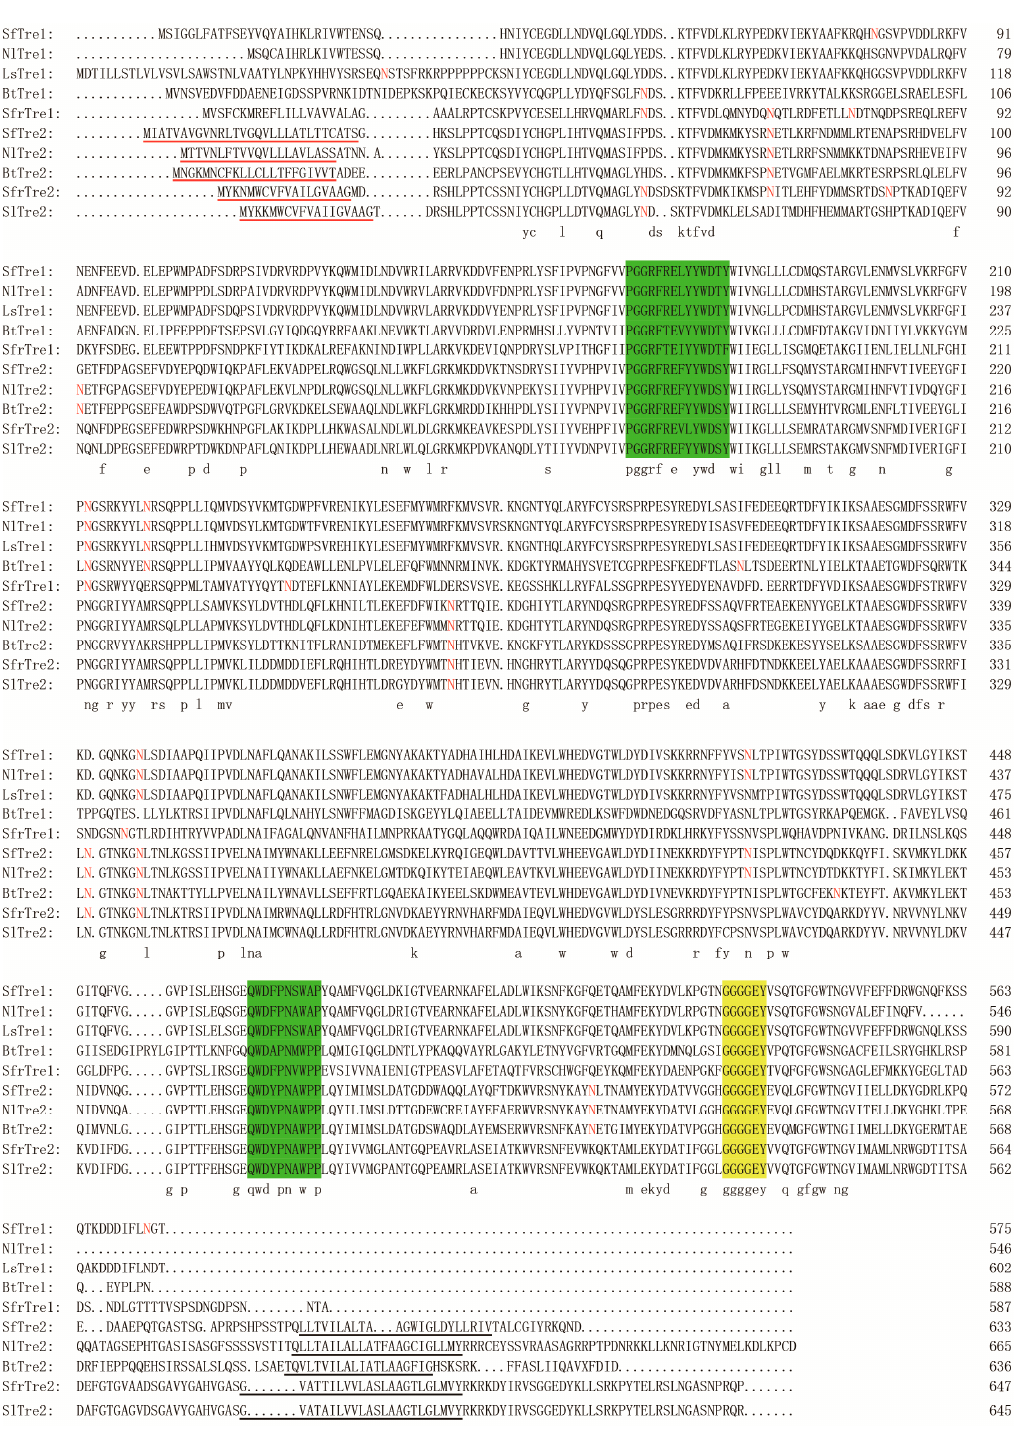
Figure 1. Multiple sequence alignment of insect trehalases was performed using DNAMAN 7. Identical amino acid residues are indicated by the letters below the sequence. The signal peptides are underlined in red, and the transmembrane regions are underlined. The trehalase signature motifs are shadowed in green, and the glycine-rich regions are shadowed in yellow. The N -glycosylation sites are in red. Abbreviations: NlTre1 and NlTre2 from Nilaparvata lugens (ACN85420 and ACV20872), LsTre1 from Laodelphax striatellus (AFL03409), BtTre1 and BtTre2 from Bemisia tabaci (AFV79626 and AFV79627), SfrTre1 and SfrTre2 from Spodoptera frugiperda (ABE27189 and ACF94698), SlTre2 from Spodoptera litura (ADA63845).